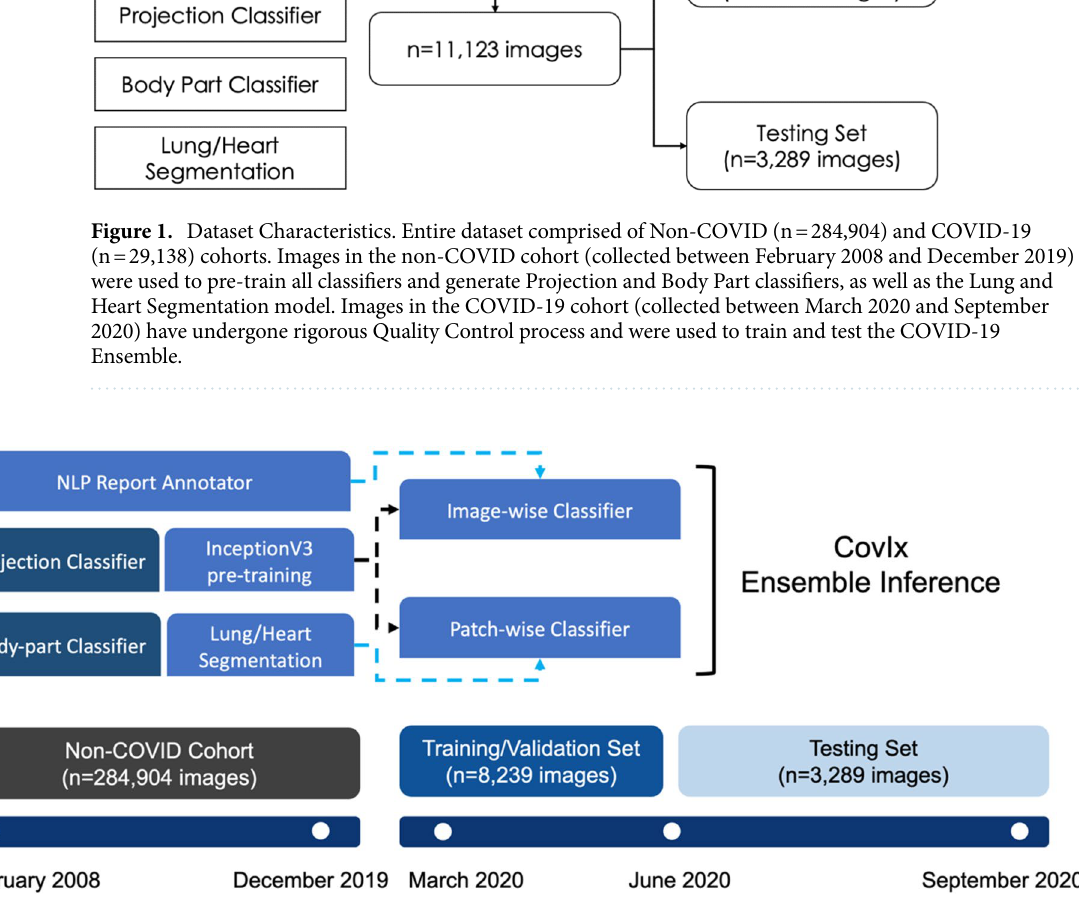
Figure 2. Study design used for the development and prospective validation of the CovIx ensemble. Non- COVID Cohort (n = 284,904 CXRs collected between February 2008 and December 2019) was used to pre-train all classifiers used in this work. CXRs collected between March and May 2020 were used to train CovIx model ensemble, whilst prospective evaluation was carried out on n = 3289 CXRs between June and September